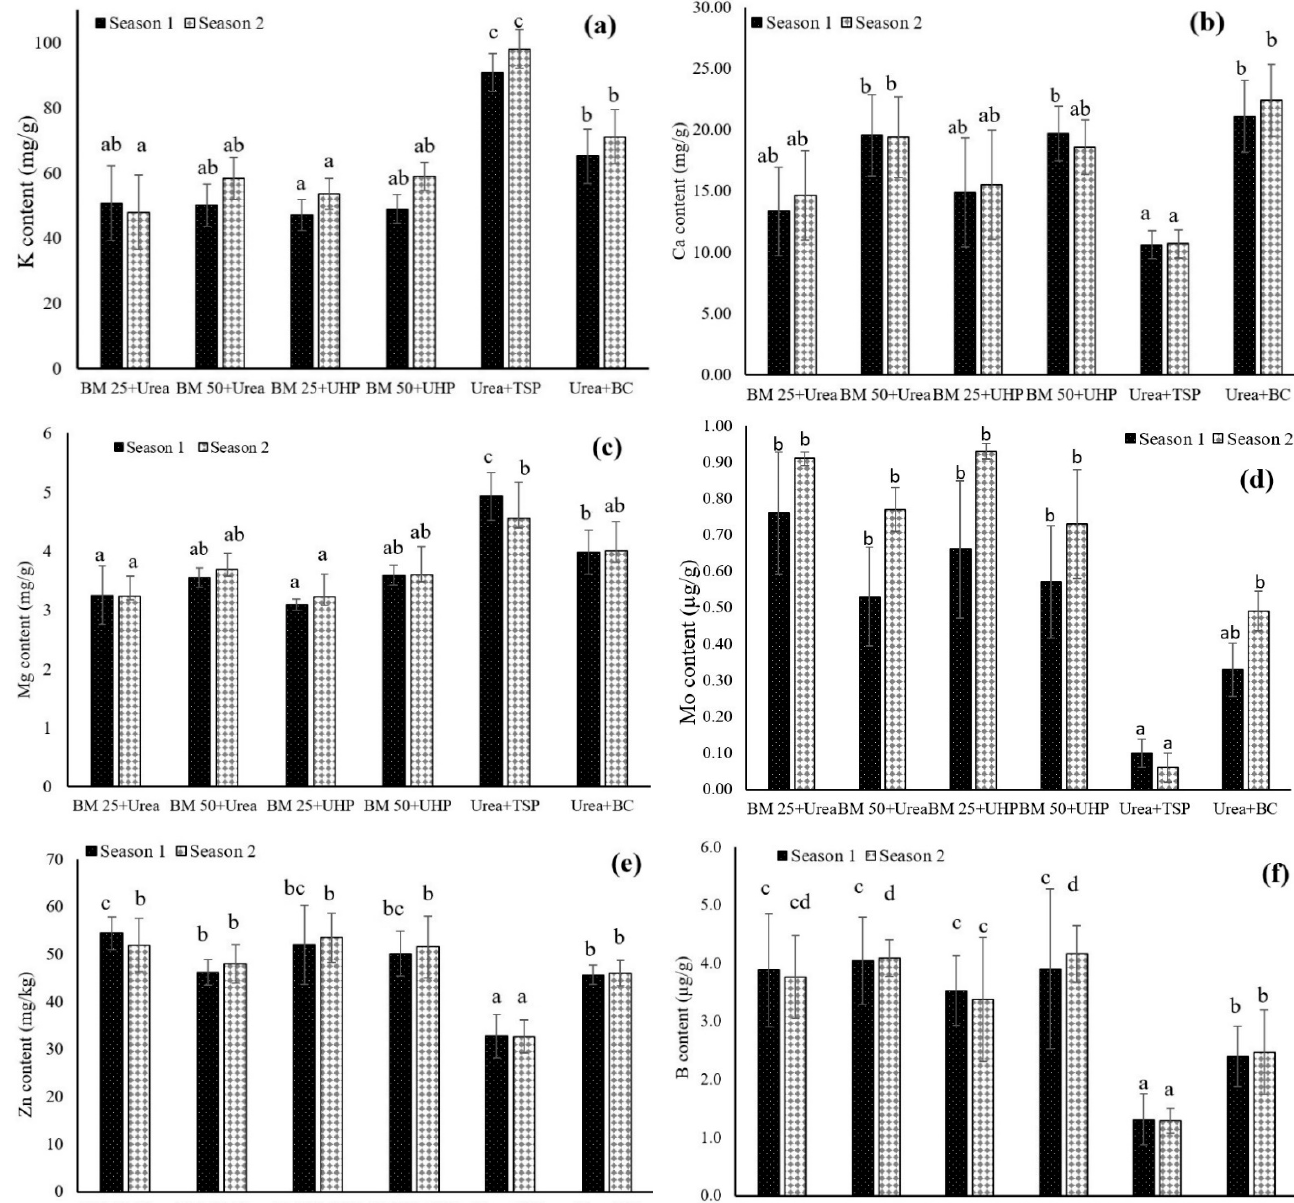
Figure 3. The quantities of ( a ) K, ( b ) Ca, ( c ) Mg, ( d ) Mo, ( e ) Zn, and ( f ) B accumulated into the leaf lettuce grown on the different amendments.